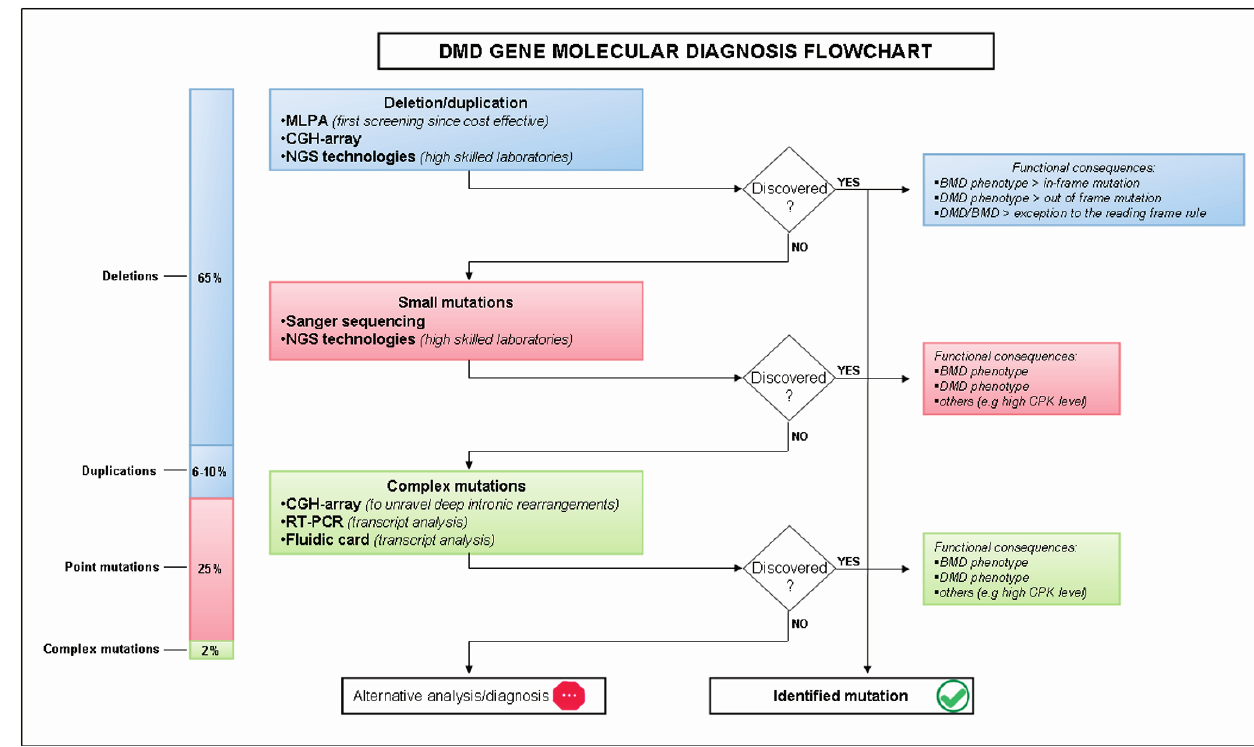
Figure 1. Flowchart of DMD diagnosis from suspicion to its confirmation. Procedures and tools for the identification of the mutation are shown. The phenotype depends on the type of mutation: DMD phenotype when the mutation alters the reading frame and leads to the complete absence of the dystrophin protein; and BMD when the mutation preserves the reading frame and allows translation of a partially functional dystrophin protein. Although, mutations that do not follow the reading frame rule are also